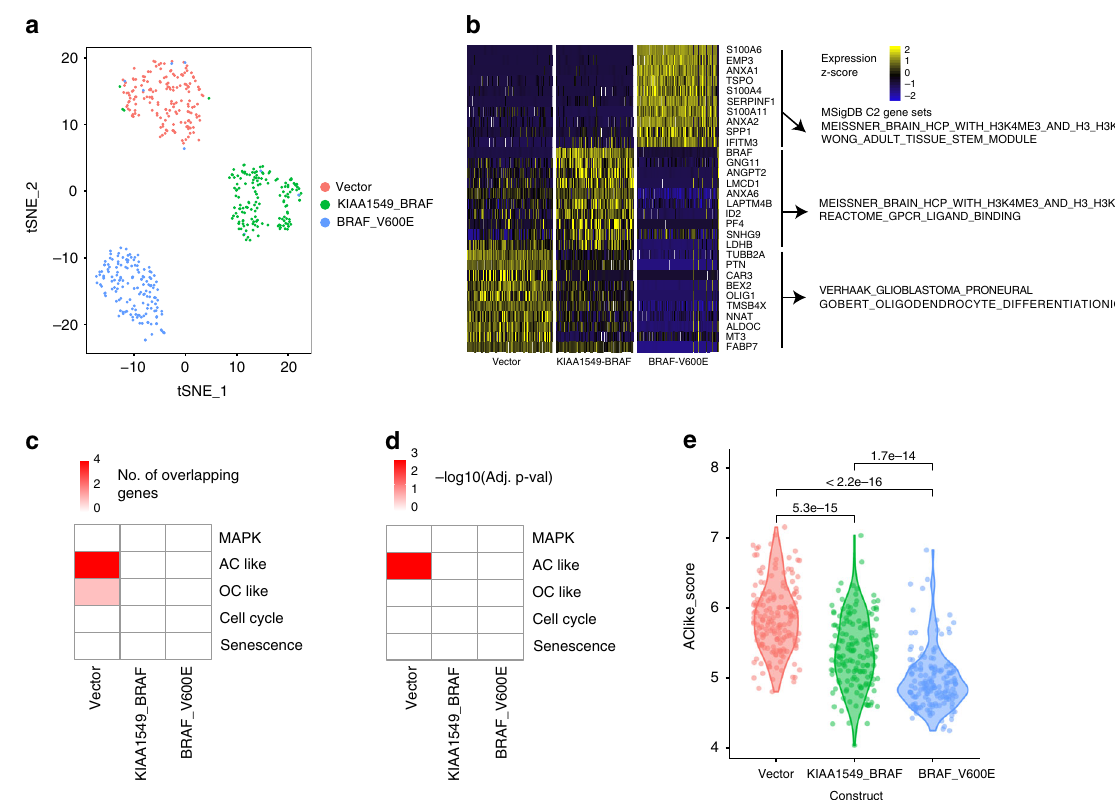
Fig. 9 Effect of oncogenic BRAF on single mouse neural stem cell transcriptomes. a t-SNE plot showing mNSCs expressing KIAA1549-BRAF, BRAF-V600E, or vector control constructs. b Heat map showing expression of the top 10 differential genes between mNSCs expressing vector control, KIAA1549-BRAF, or BRAF-V600E constructs. Selected C2 MSigDB gene sets that signi fi cantly overlapped with the top 50 differentially expressed genes for each group are shown, along with FDR q-values for signi fi cance of overlap using hypergeometric test with Bonferroni correction. c Heat map showing number of genes overlapping between list of top 50 genes differentially expressed between mNSC groups and PA-derived gene programme. d Heat map showing − log10 of P -value for signi fi cance of overlap between gene lists using a Fisher ’ s exact test with a Bonferroni correction. e Violin plot showing AC-like gene programme score for mNSCs expressing vector control, KIAA1549-BRAF, or BRAF-V600E constructs. P -values are for Kruskal – Wallis pairwise